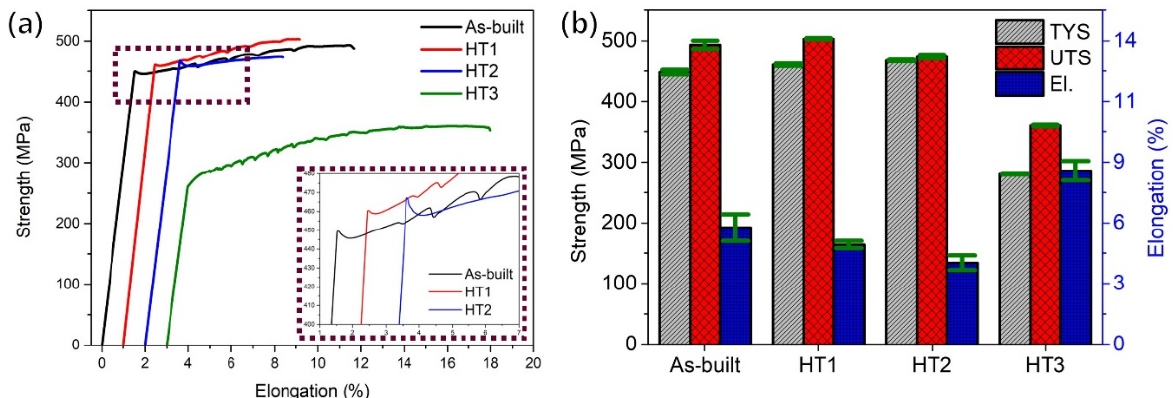
Figure 12. Variation in mechanical properties: ( a ) stress–strain curve and ( b ) average tensile test values. Table 3. Tensile test results of various heat treatment conditions.